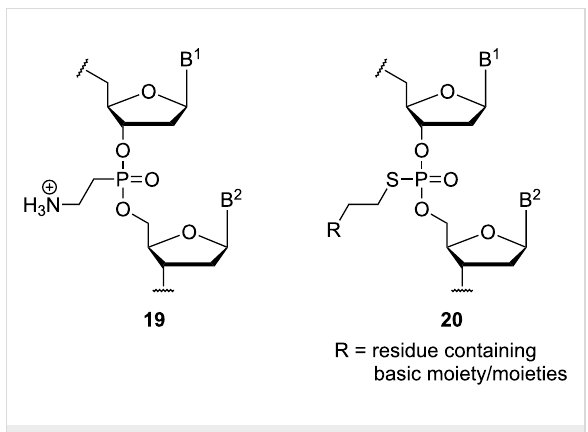
Figure 4: Artificial cationic backbone linkages 19 and 20 which are structurally related to aminoalkylated phosphoramidates of type 7 (B 1 , B 2 =